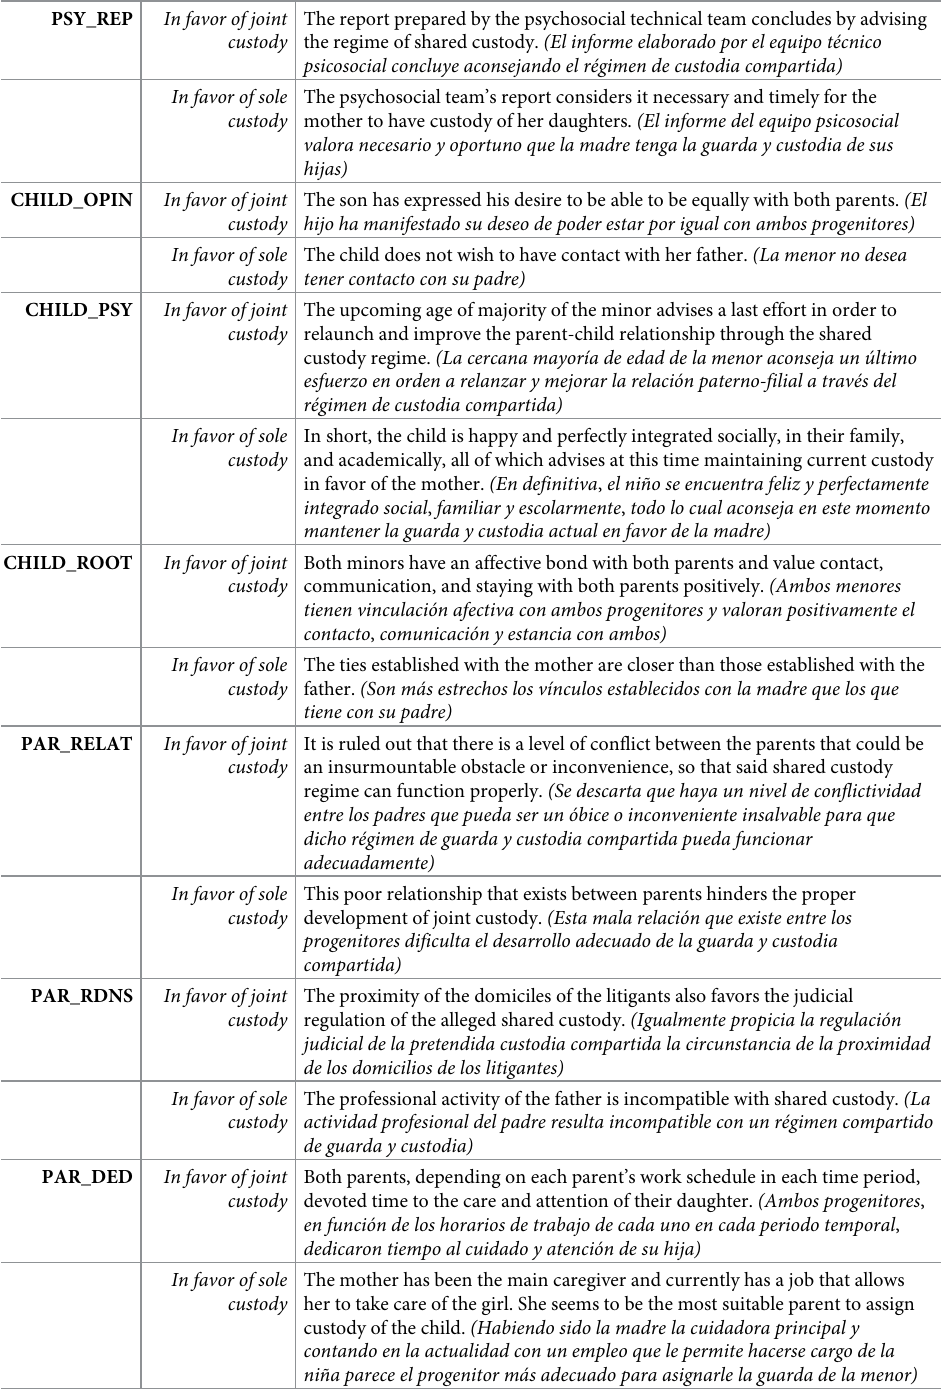
Table 2. Examples of phrases identified in the court sentences for each of the factual elements and legal